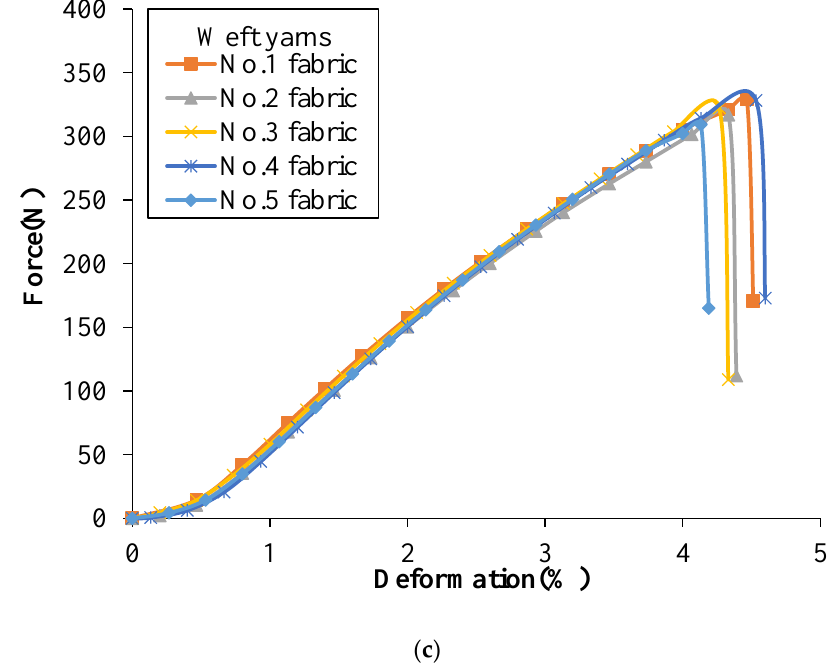
Figure 4. Tensile force vs. deformation curves of a single yarn after weaving in different 3DWIFs: ( a ) binding warp, ( b ) stuffer warp and ( c ) weft yarns.